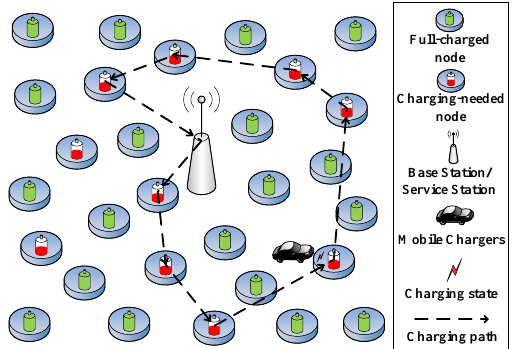
Figure 2. Network architecture.